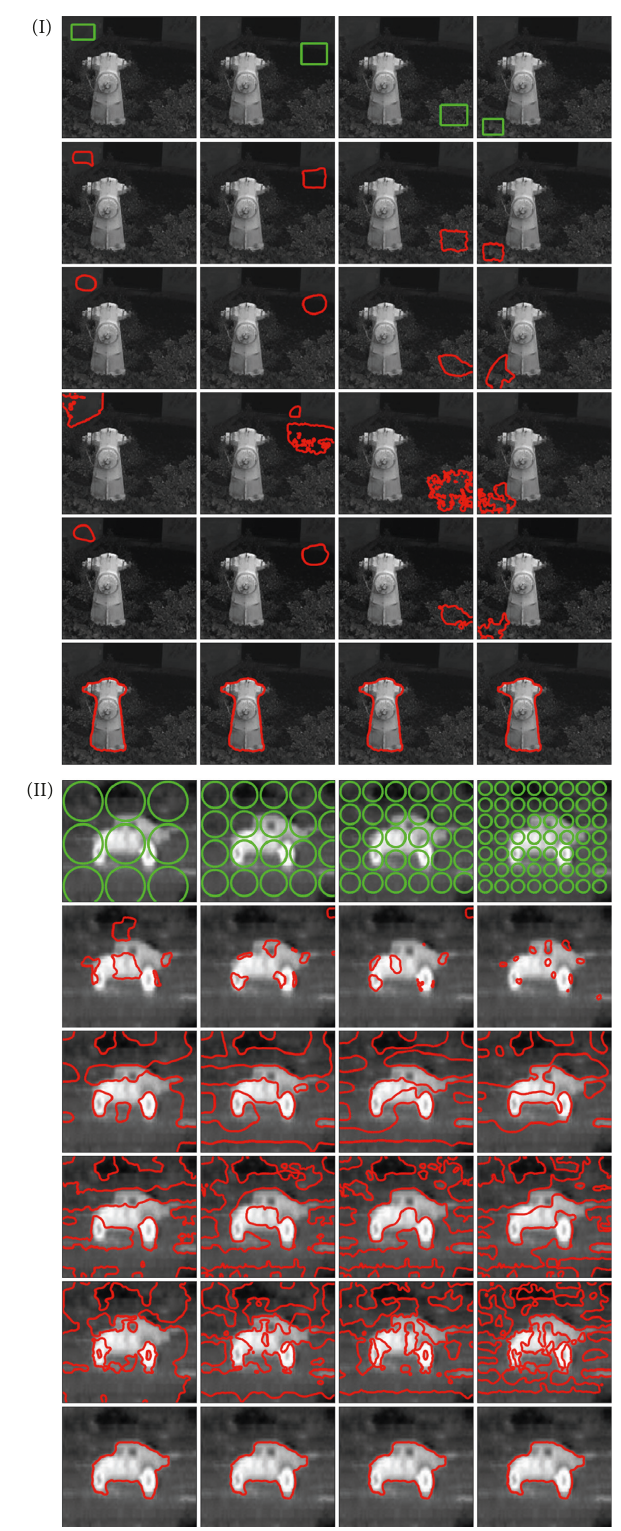
Figure 7: Demonstration experiment for testing the insensitivity of the comparison models to initializations. Subgroup (I): the first row of (I) is the input image along with the initial contours, while the second to sixth rows of (I) correspond to the final contours of LSEWR, RSF, LGDF, LIF, and our SP-LSM models, respectively. Subgroup (II): the data layout of (II) is the same as that of (I). The relevant task parameters are μ � 0 . 03, Δ t � 7, σ � 1 . 5, and ε � 2 .